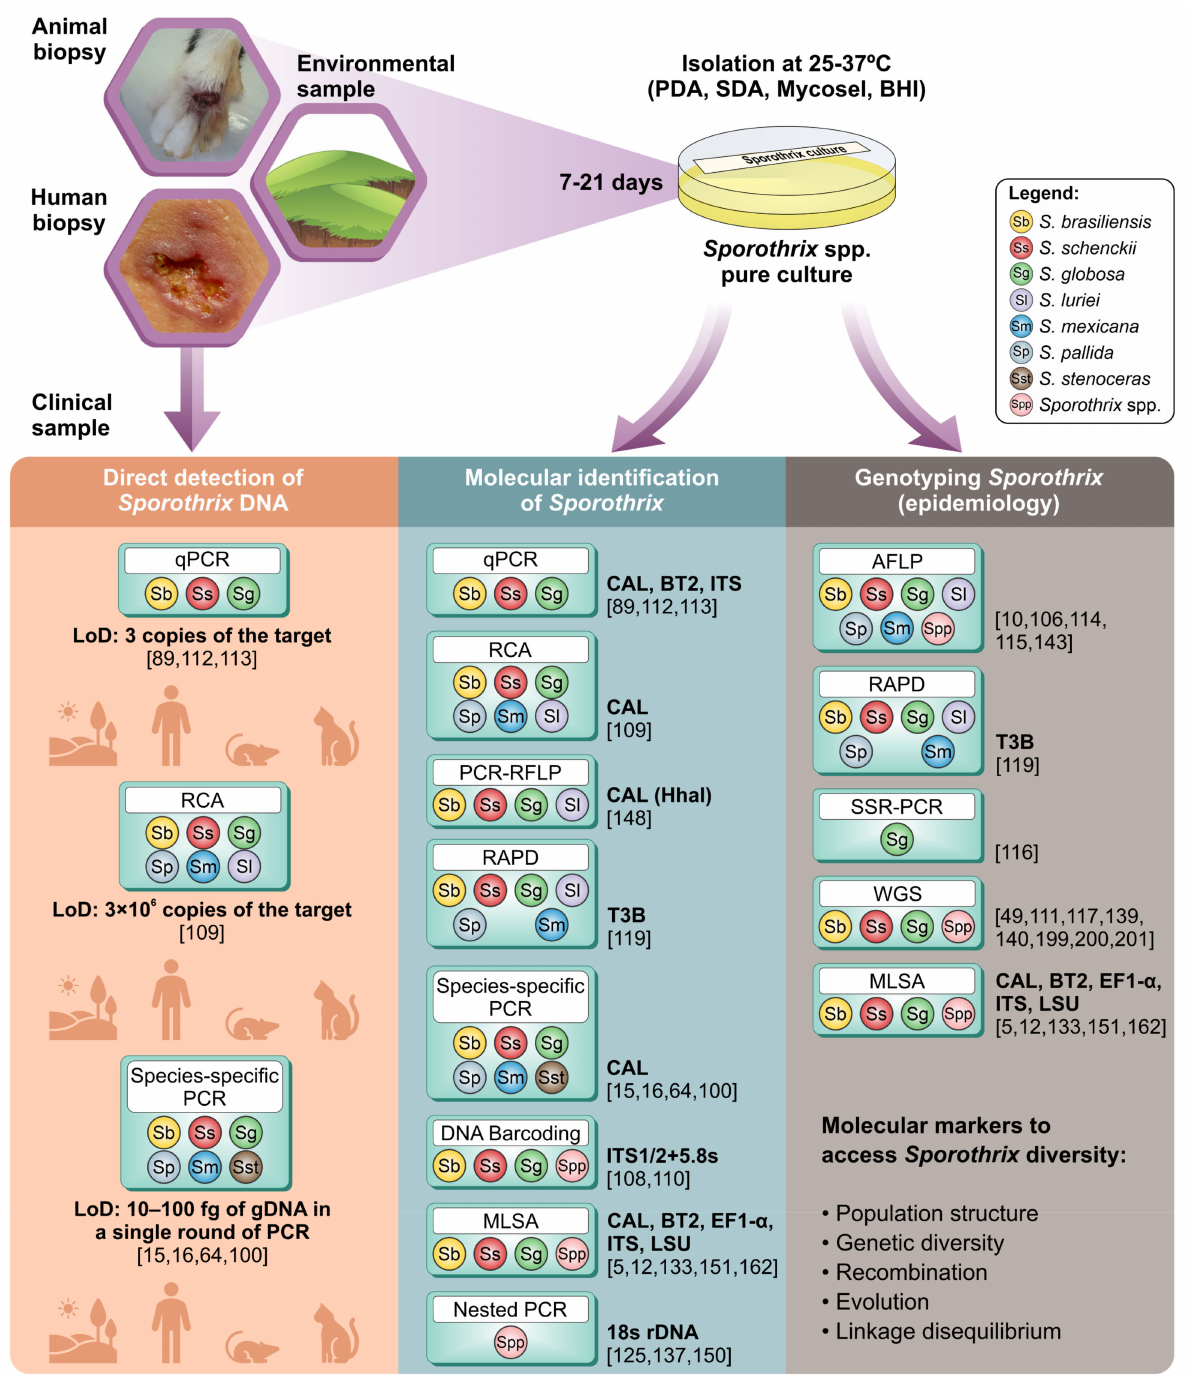
Figure 10. Schematic representation of Sporothrix species molecular detection/identification strate- gies, directly from clinical and/or environmental samples (orange panel) or gDNA extracted from cultured isolates (blue and brown panel). PCR: polymerase chain reaction; PCR-RFLP: polymerase chain reaction-restriction fragment length polymorphism; RCA: rolling circle amplification; qPCR: quantitative polymerase chain reaction; MLSA: multi-locus sequence analysis; AFLP: amplified fragment length polymorphism; SSR: simple sequence repeats; WGS: whole-genome sequencing; RAPD: randomly amplified polymorphic DNA; LoD: limit of